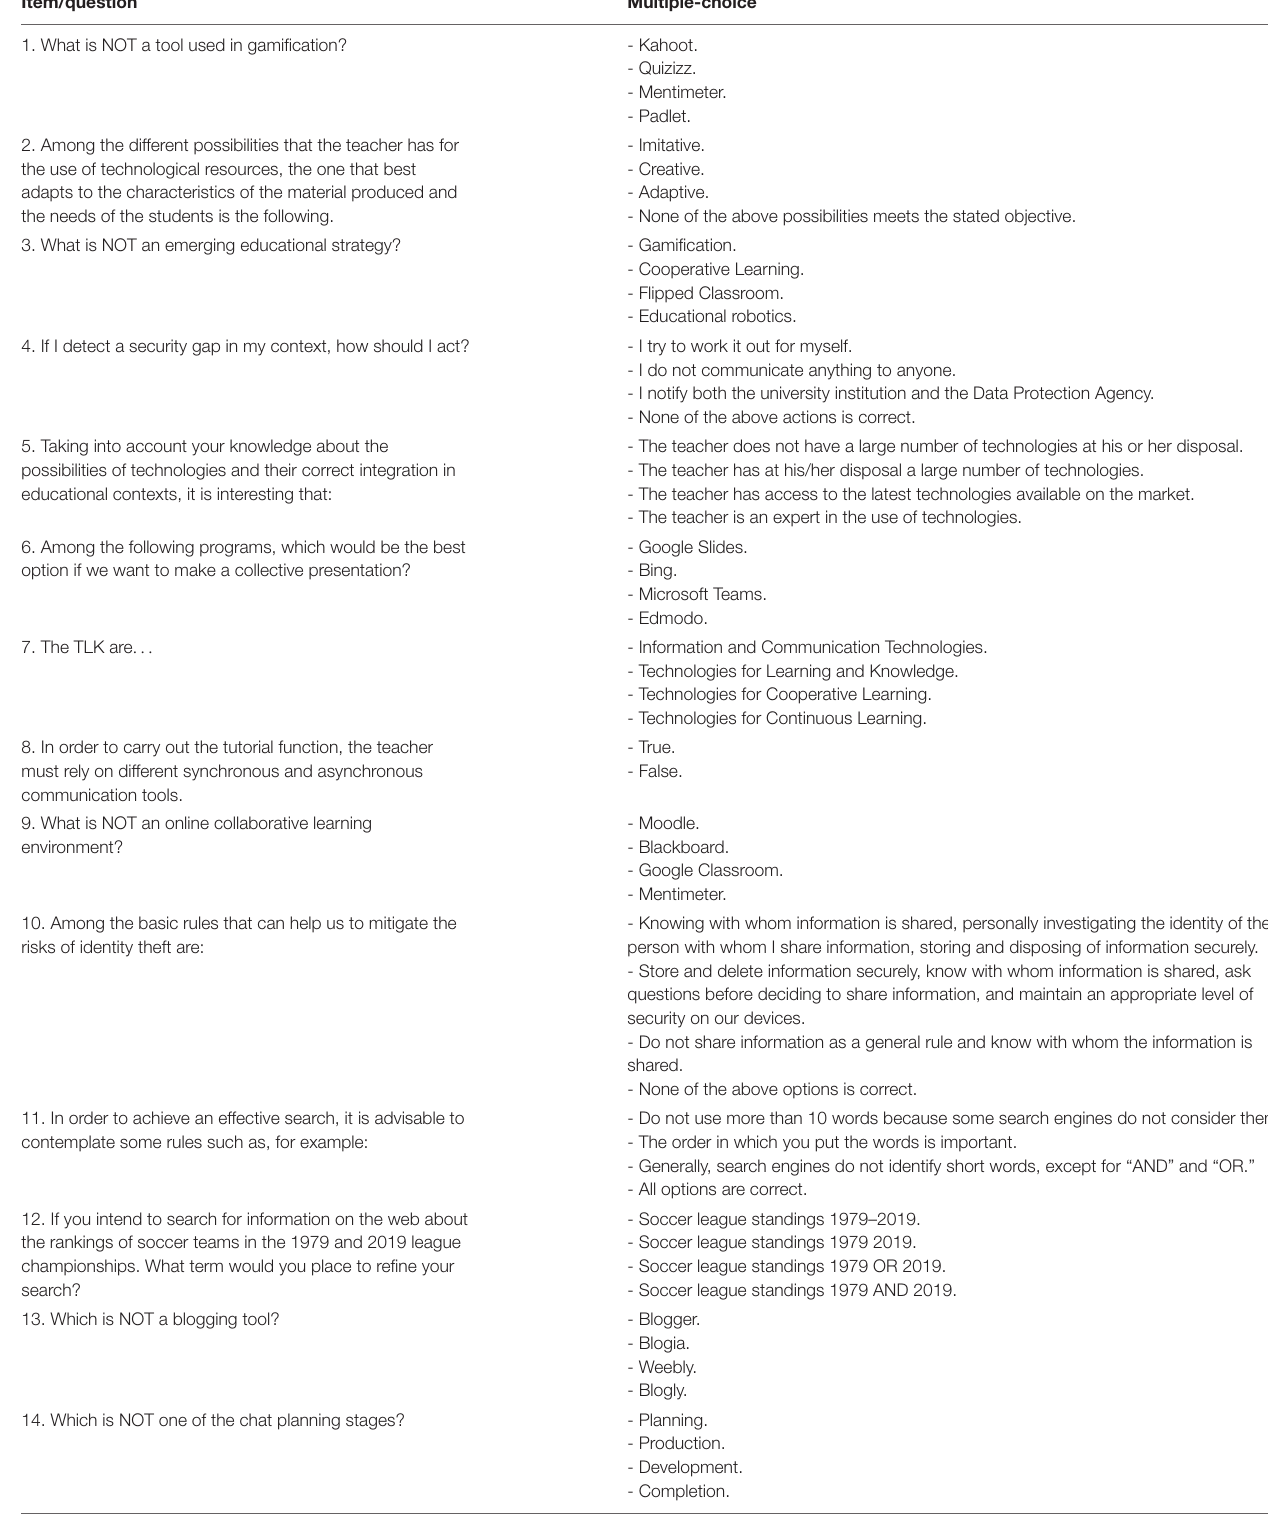
TABLE 2 | Transfer massive open online courses content questionnaire.